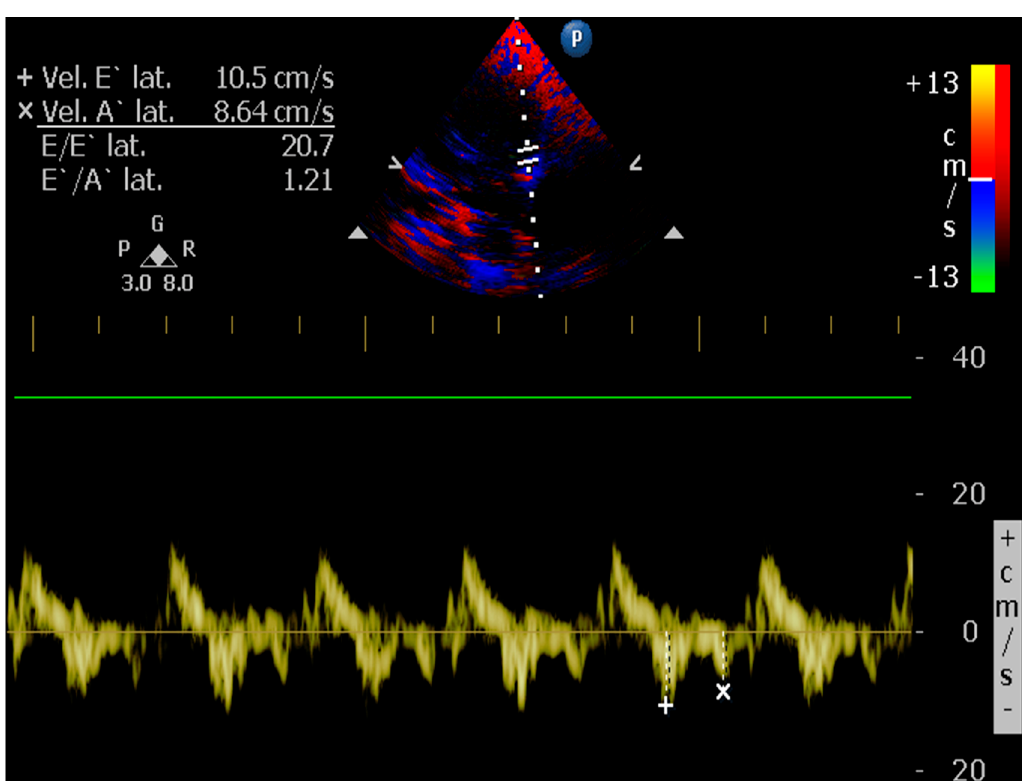
Figure 12. Altered E/e ratio in a canine patient with congestive heart failure.